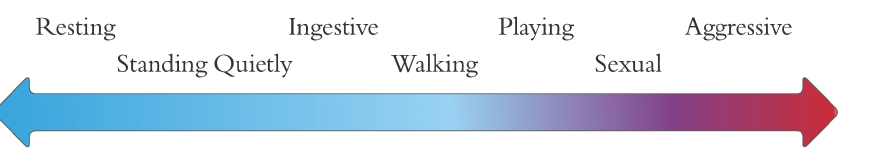
Figure 1. Hypothetical continuum of approximate physiological arousal levels for seven observed categories of behavior.